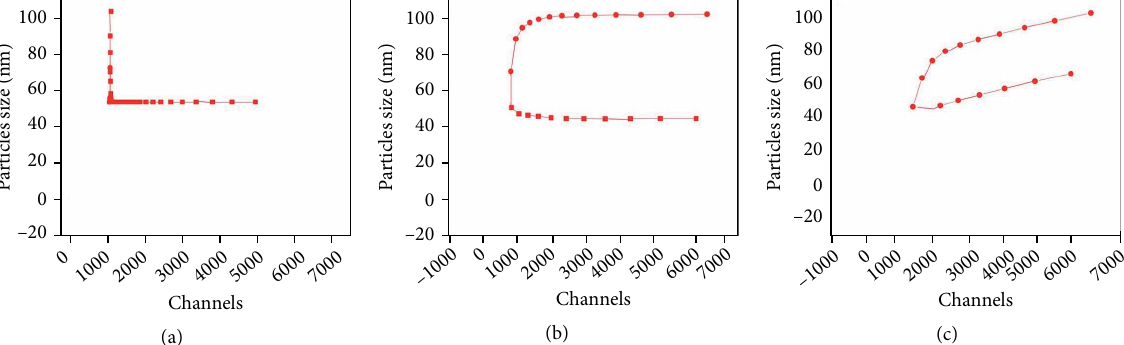
Figure 8: Particles size distribution of prepared nanomaterials. (a) TiO